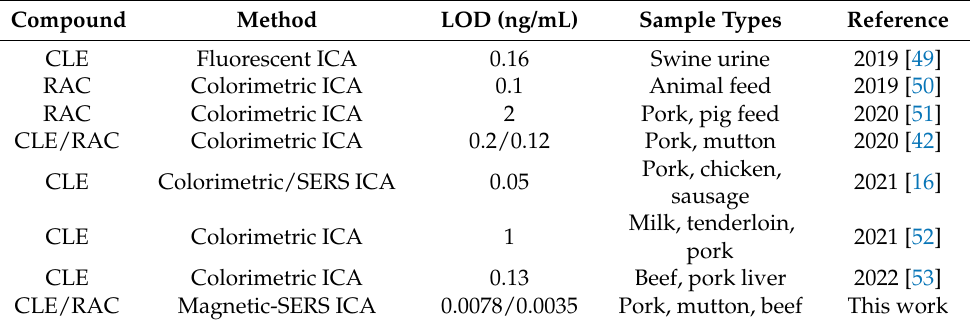
Figure 3. ( a ) Diagrams of ( i ) the magnetic enrichment effect of Mag@Au tags in complex samples and ( ii ) the corresponding SERS signal intensity at 1331 cm − 1 after enrichment. The detection results of CLE and RAC are based on Mag@Au-ICA in the ( b ) unenriched and ( c ) enriched modes. Diagrams of the test strips ( i ) and the corresponding SERS signal ( ii ) in the ( b ) non-enriched mode and ( c ) enriched mode. The error bar is the standard deviation of the five independent tests based on Mag@Au-ICA. Table 1. Comparison with other immunochromatographic